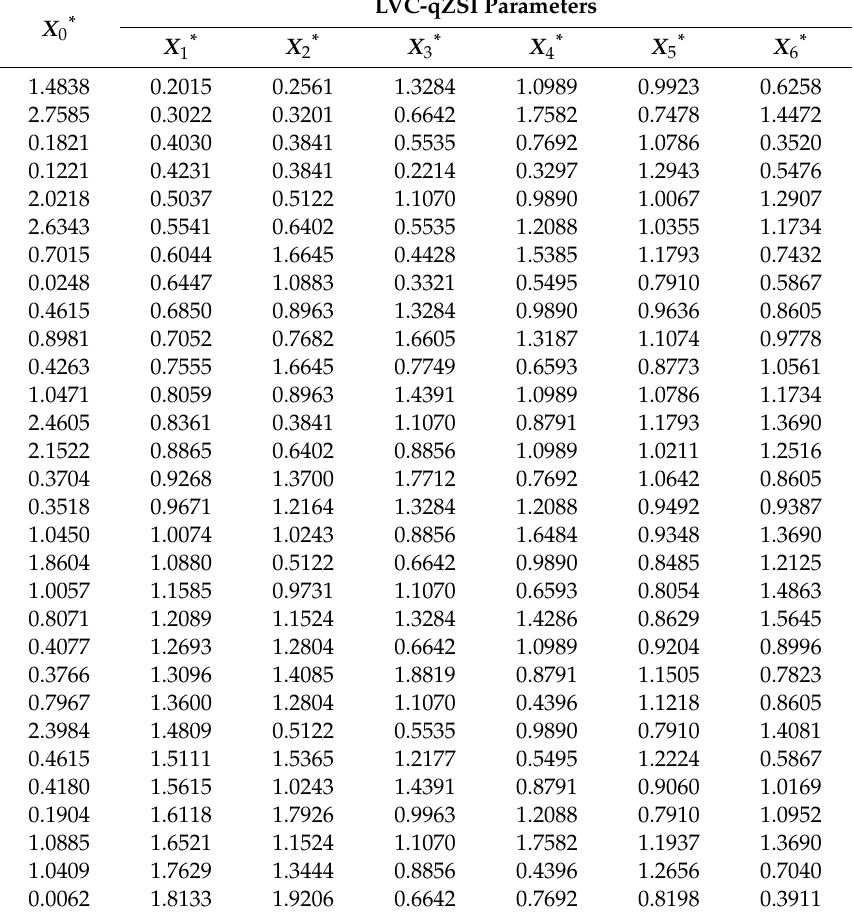
Table 3. Dimensionless matrix of LVC-qZSI